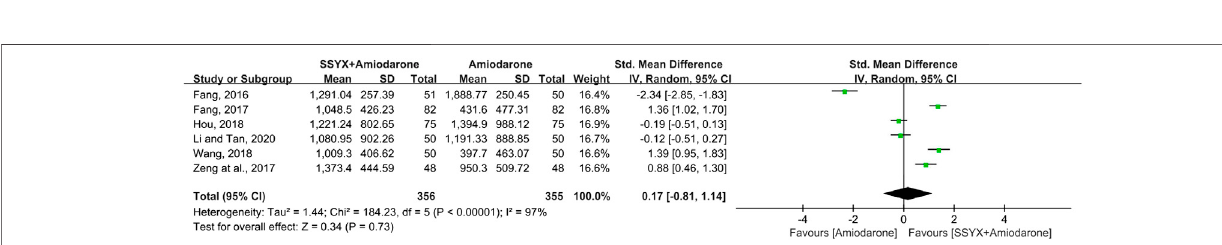
FIGURE 6 | Forest plot of comparison: SSYX-amiodarone vs. amiodarone alone: LVEF.